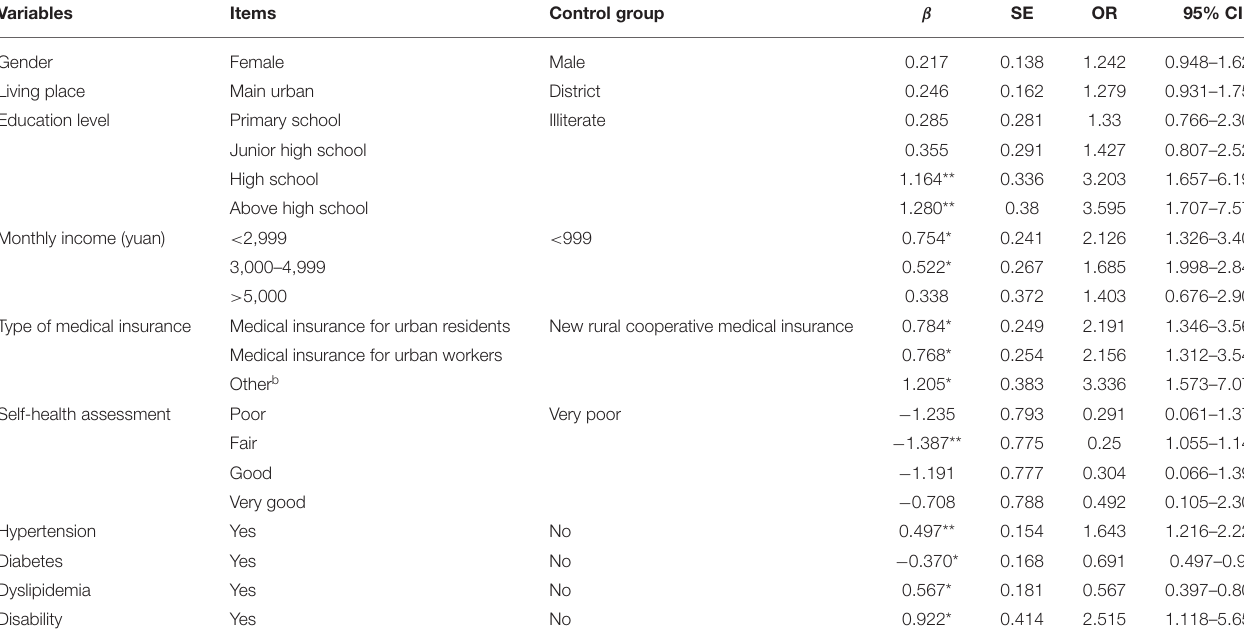
TABLE 4 | Multivariate logistic regression